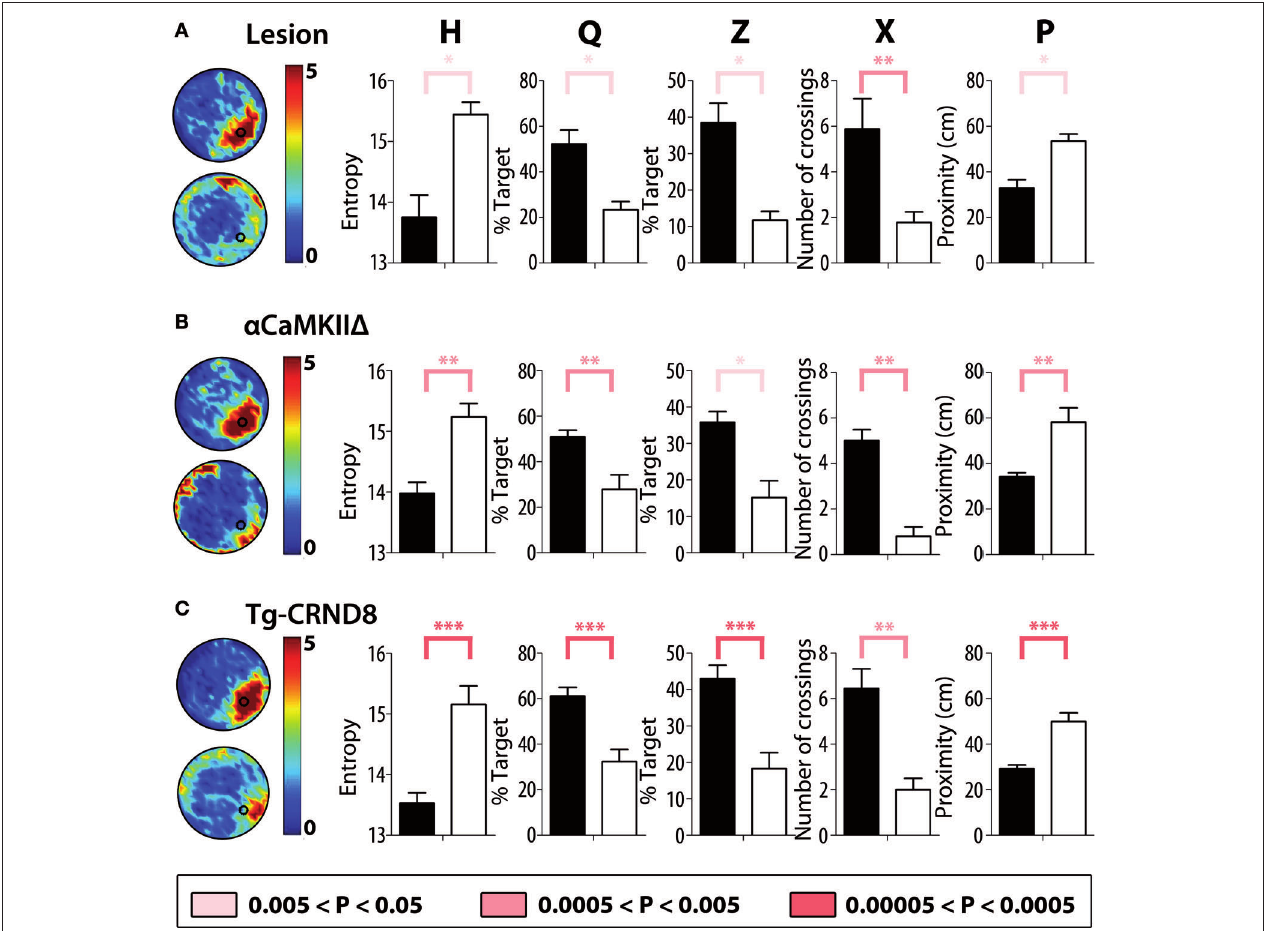
FIGURE 8 | Validation of H with three models of experimentally induced hippocampal dysfunction. In these experiments mice were trained in the water maze for 3 days (six trials per day) and a probe test was given at the completion of training. (A) Left, density plots of probe test performance of control (top) and lesioned (bottom) mice. The color scale represents the number of visits per animal per 5 cm × 5 cm area. Right, comparison of the respective groups using H , Q , Z , X , and P measures. (B) Left, density plots of